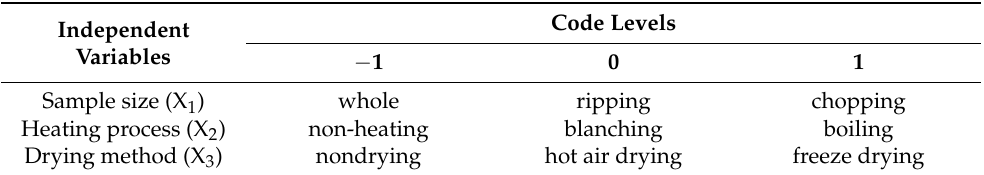
Table 1. The codes of an independent variable on the factorial experimentations for the biogenic amine